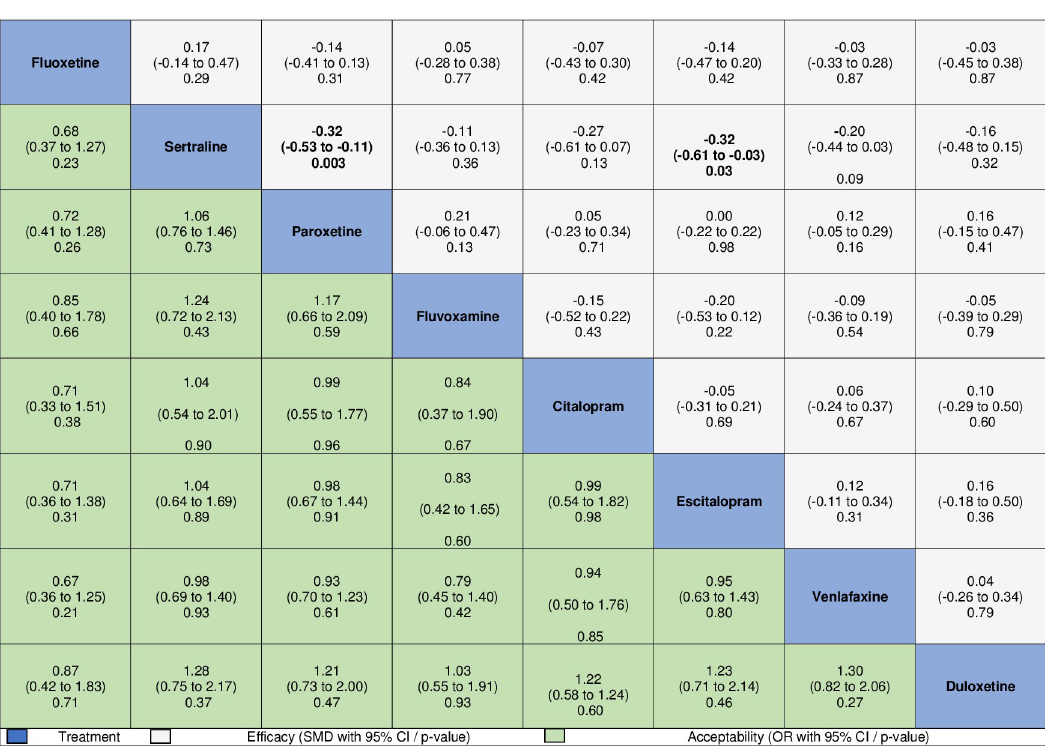
Fig 4. Comparisons of efficacy and discontinuation rates of all selective serotonin reuptake inhibitors and serotonin and norepinephrine reuptake inhibitors, considering 3-level multiple meta-regression models. Comparisons between treatments should be read from left to right, and the estimate is in the cell in common between the column-defining treatment and the row- defining treatment. For efficacy, standardized mean differences (SMDs) below 0 favor the column-defining treatment. For safety, odds ratio (ORs) above 1 favor the column-defining